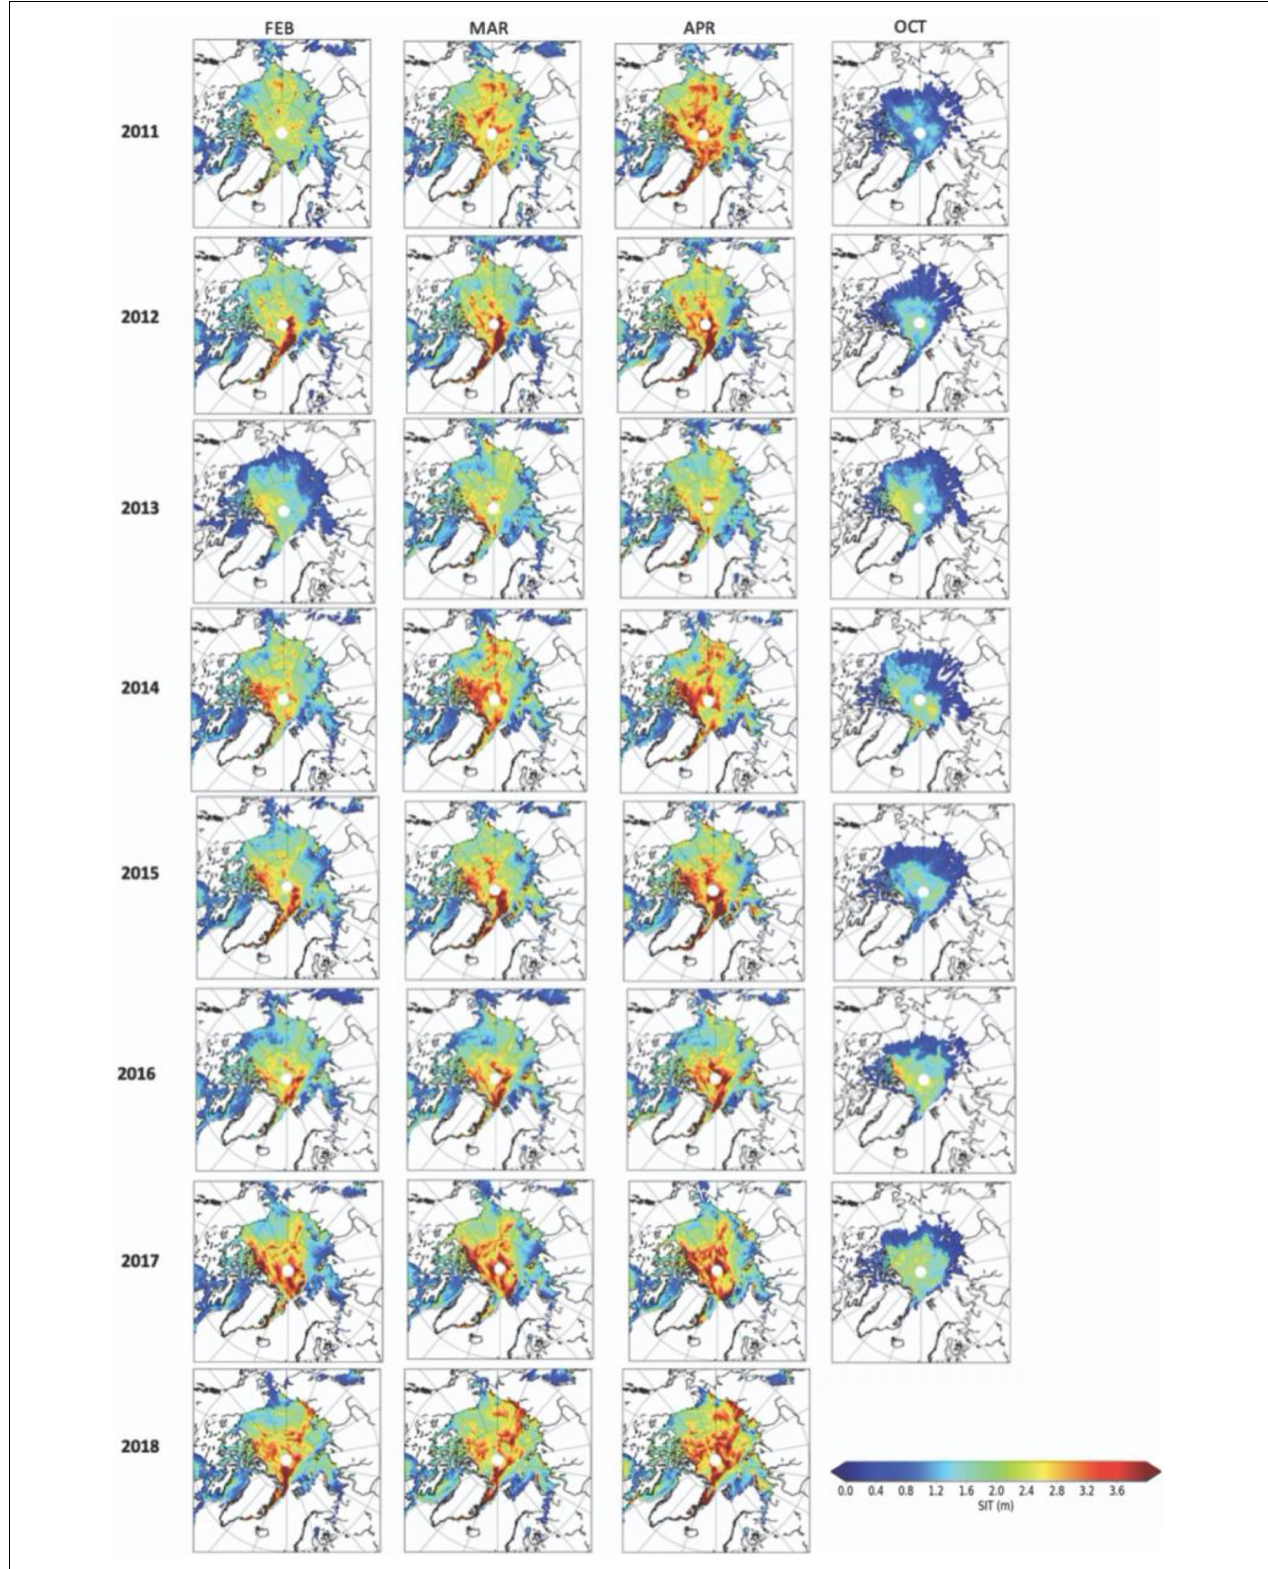
FIGURE 6 | Summary of the monthly mean ice thickness for all months and all years from February 2011 to April 2018.